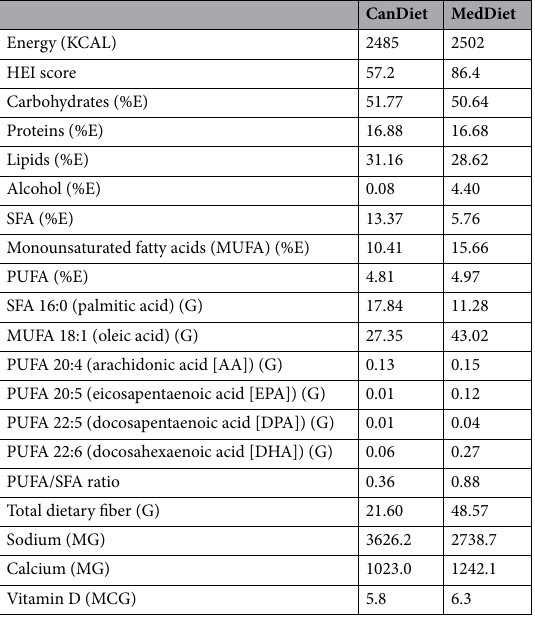
Table 2. Macronutrients and micronutrients composition of the CanDiet and the